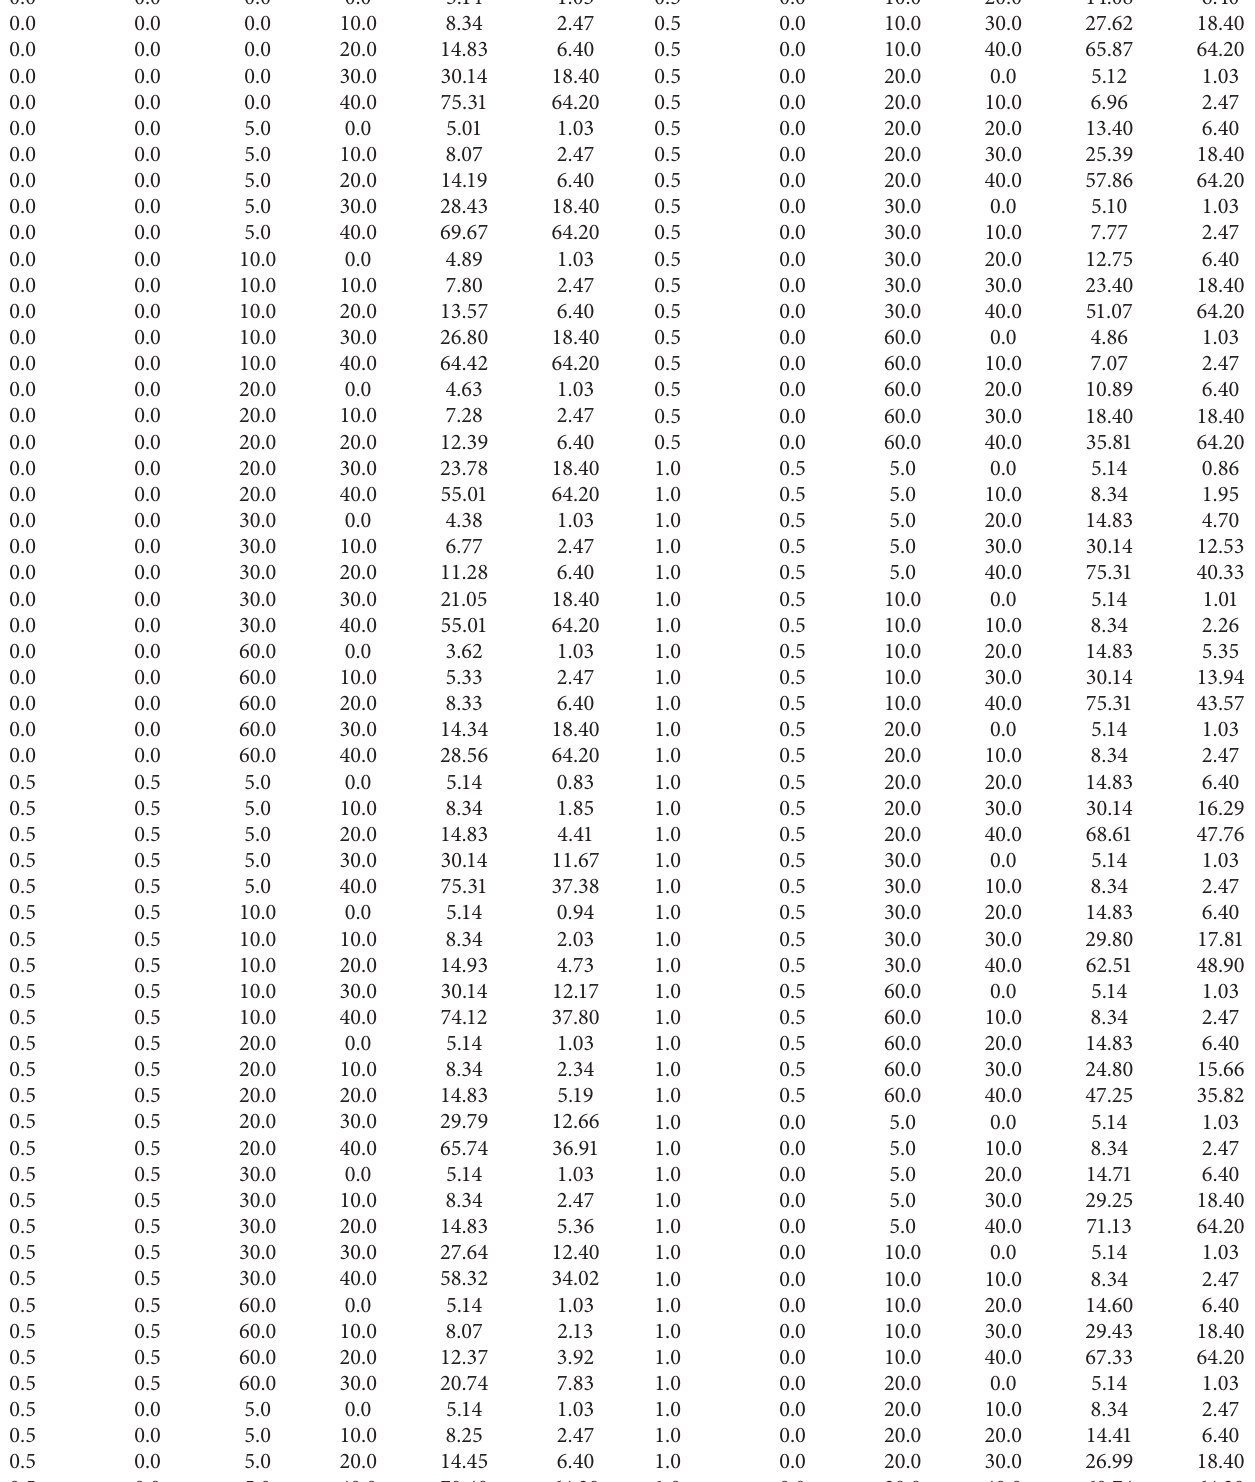
Table 1: The used